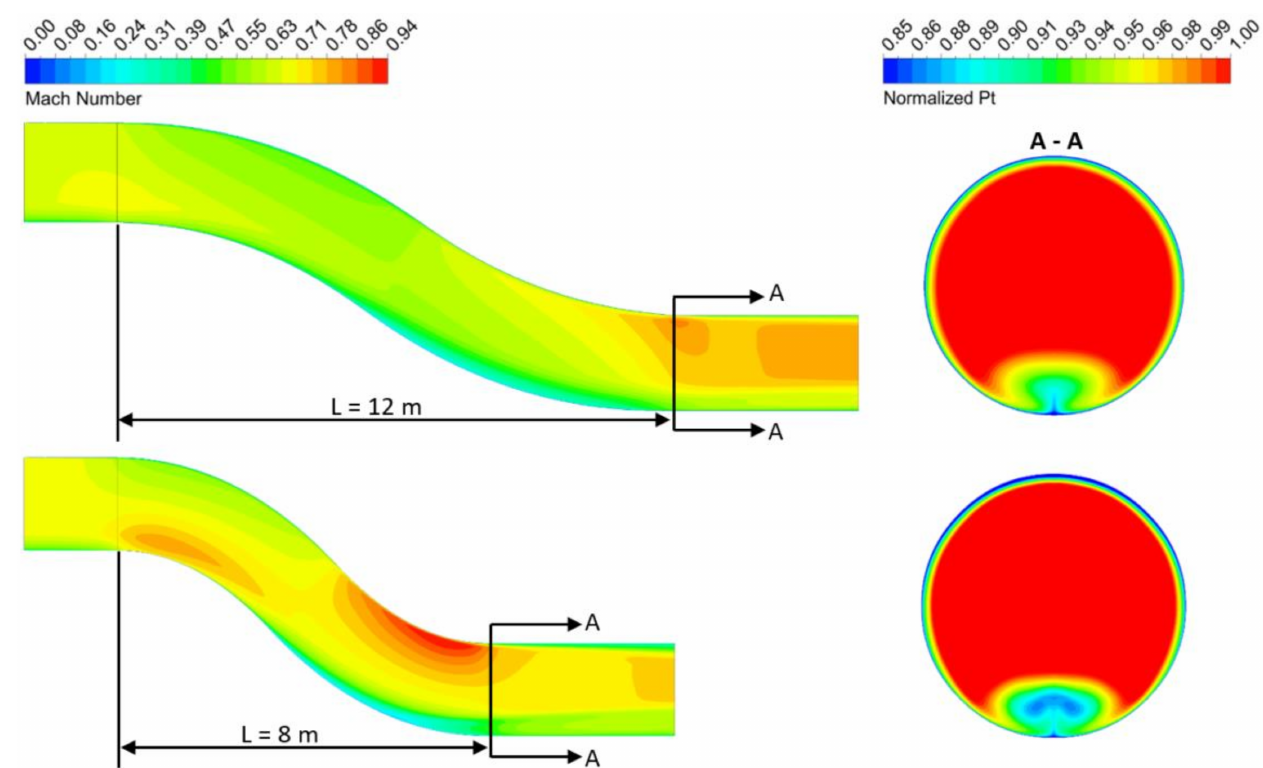
Figure 15. Comparison of the symmetry plane Mach number contours and the normalized total pressure distribution at the engine inlet (top: optimal distortion, bottom: undeformed